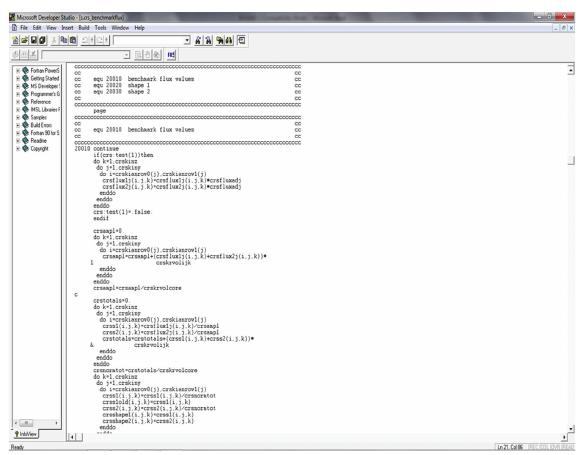
Figure 3: Modified REMARK code in Fortran language.